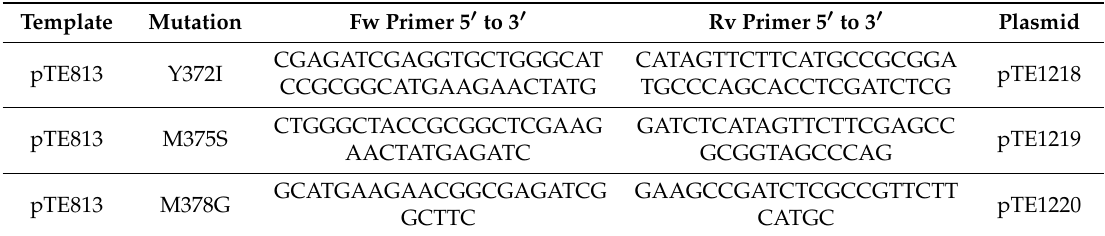
Table 2. Plasmids and primers used for site-directed